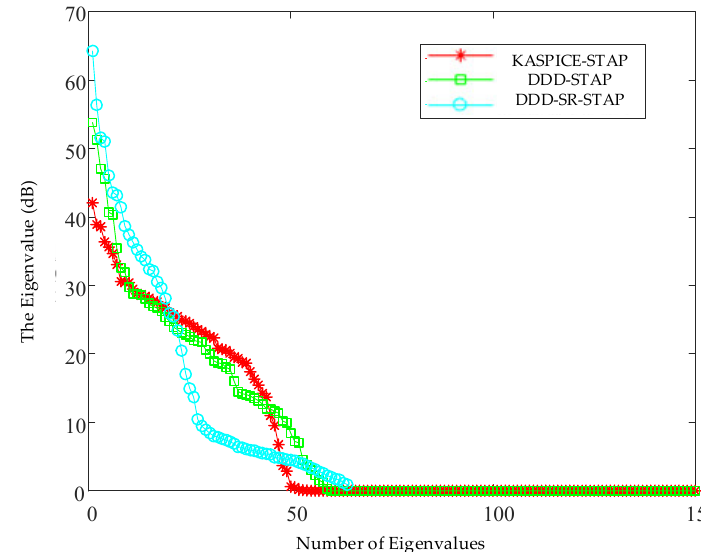
Figure 7. Clutter characteristic spectrum.